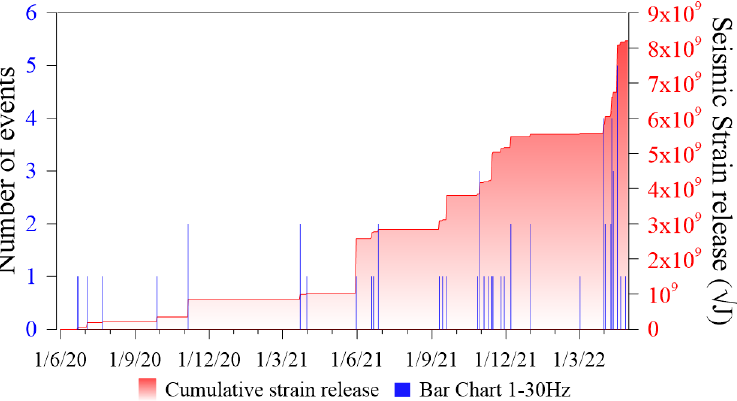
Figure 16. Daily occurrence rate (blue lines) and cumulative strain release (red area) of the ML ≥ 1 earthquakes that occurred in the Vulcano area (coordinates 38.32N–14.84E and 38.48N–15.07E) in the period 01/06/2020-30/04/2022. of 2–15 km (Figure 17).